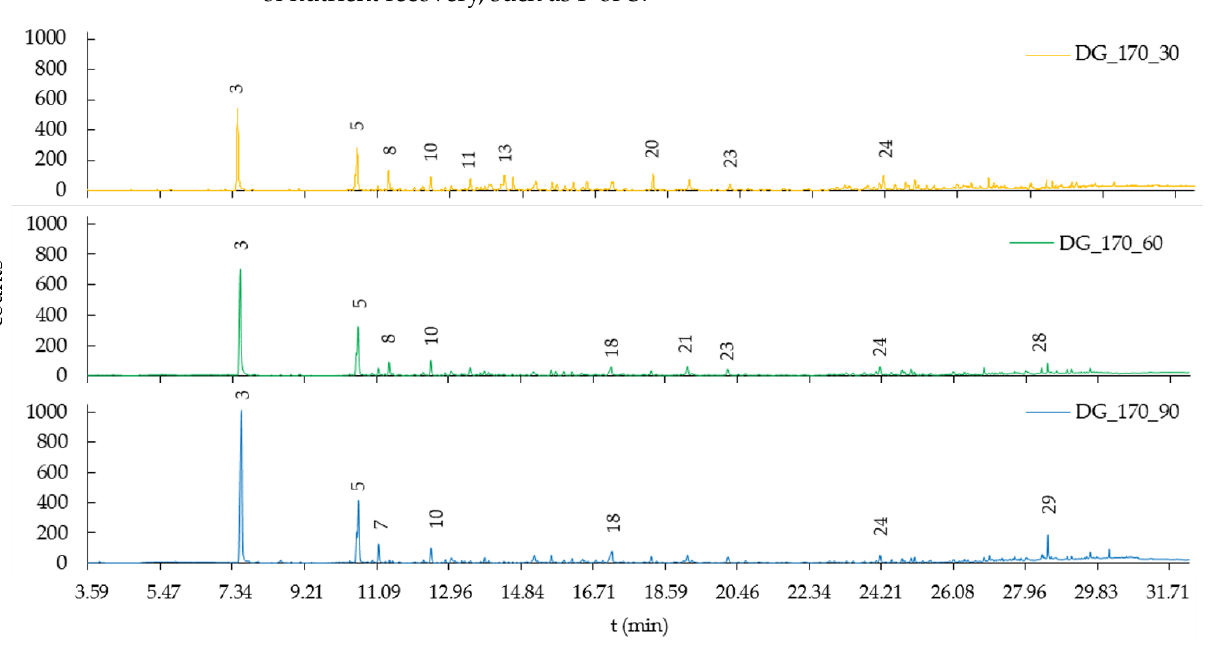
Figure 4. GC-MS diagram of the digestate (DG) hydrothermally treated at 170 °C with 30, 60 and 90 min holding times, see peak numbers in Table 6.